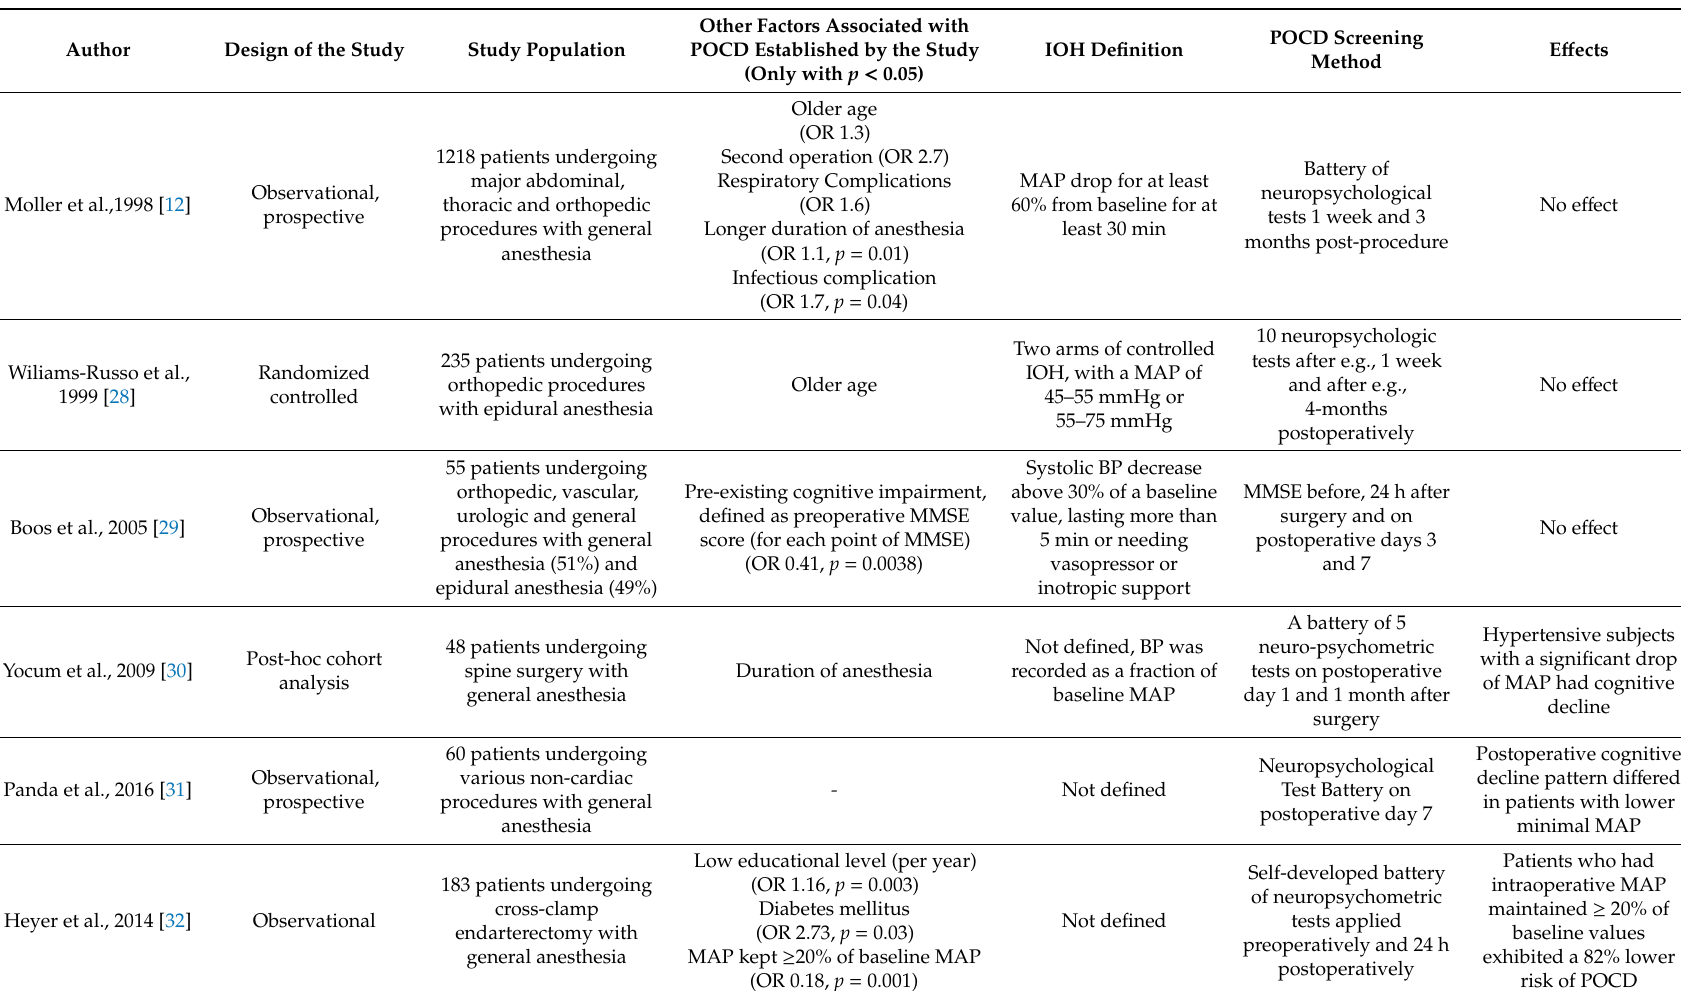
Table 5. Summary of studies on the association between intraoperative hypotension (IOH) or intraoperative blood pressure drop and postoperative cognitive decline (deficit)